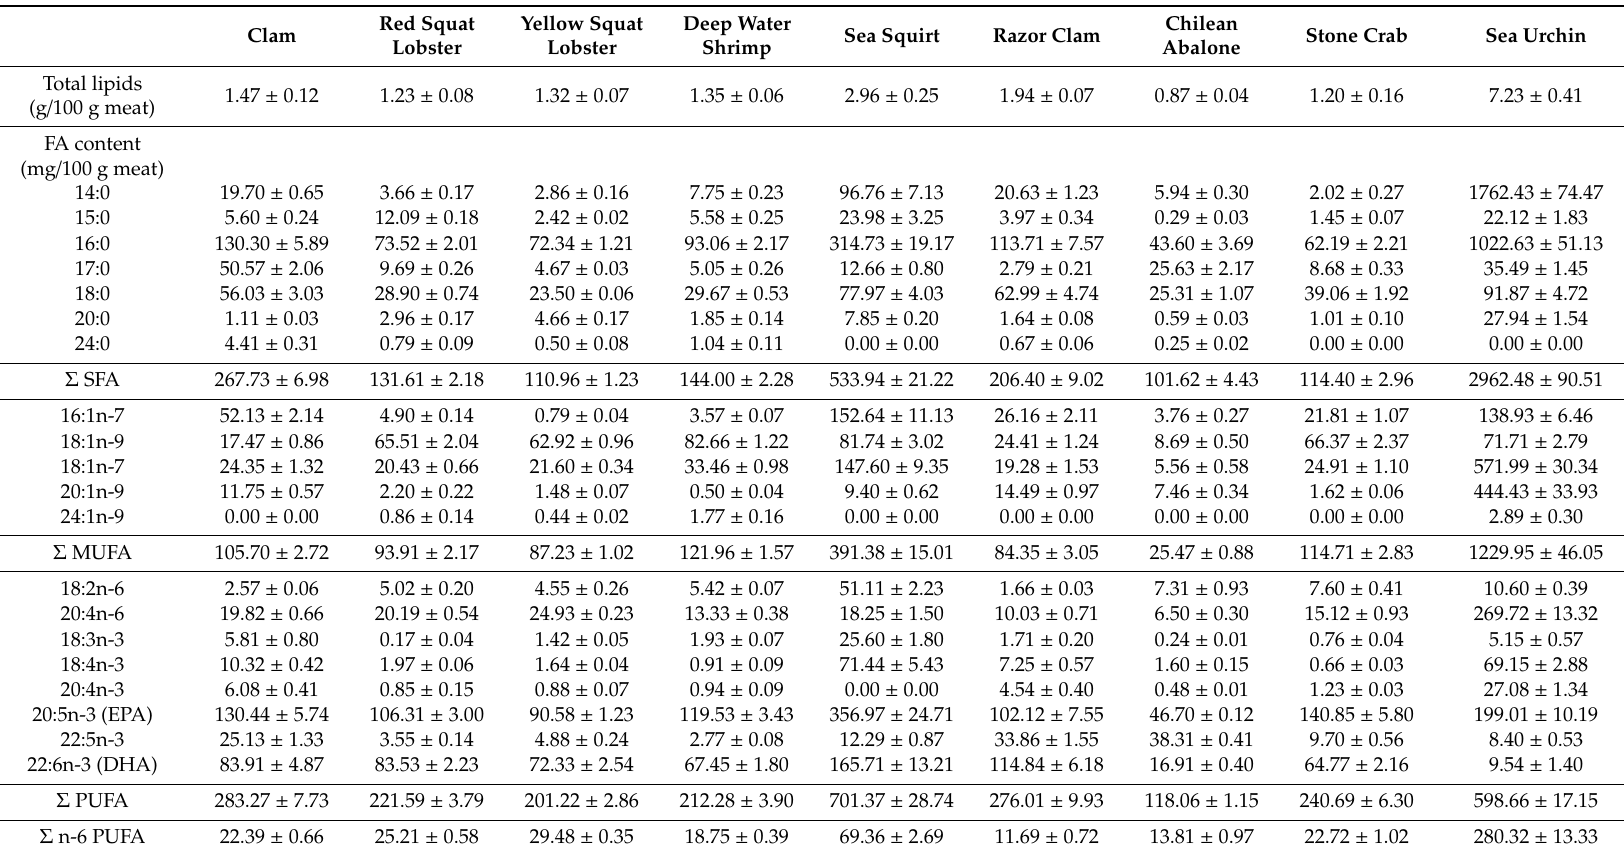
Table 3. Total extracted lipids (g / 100 g raw meat) and amounts of each fatty acid (mg / 100 g raw meat) in shellfish. Data are reported as mean ± standard deviation. Nutritional indexes (HH, PUFA / SFA and n-6 / n-3 ratios) and amounts of raw fish flesh needed to provide the minimum recommended daily amount of EPA + DHA (250 mg) for healthy adults are also